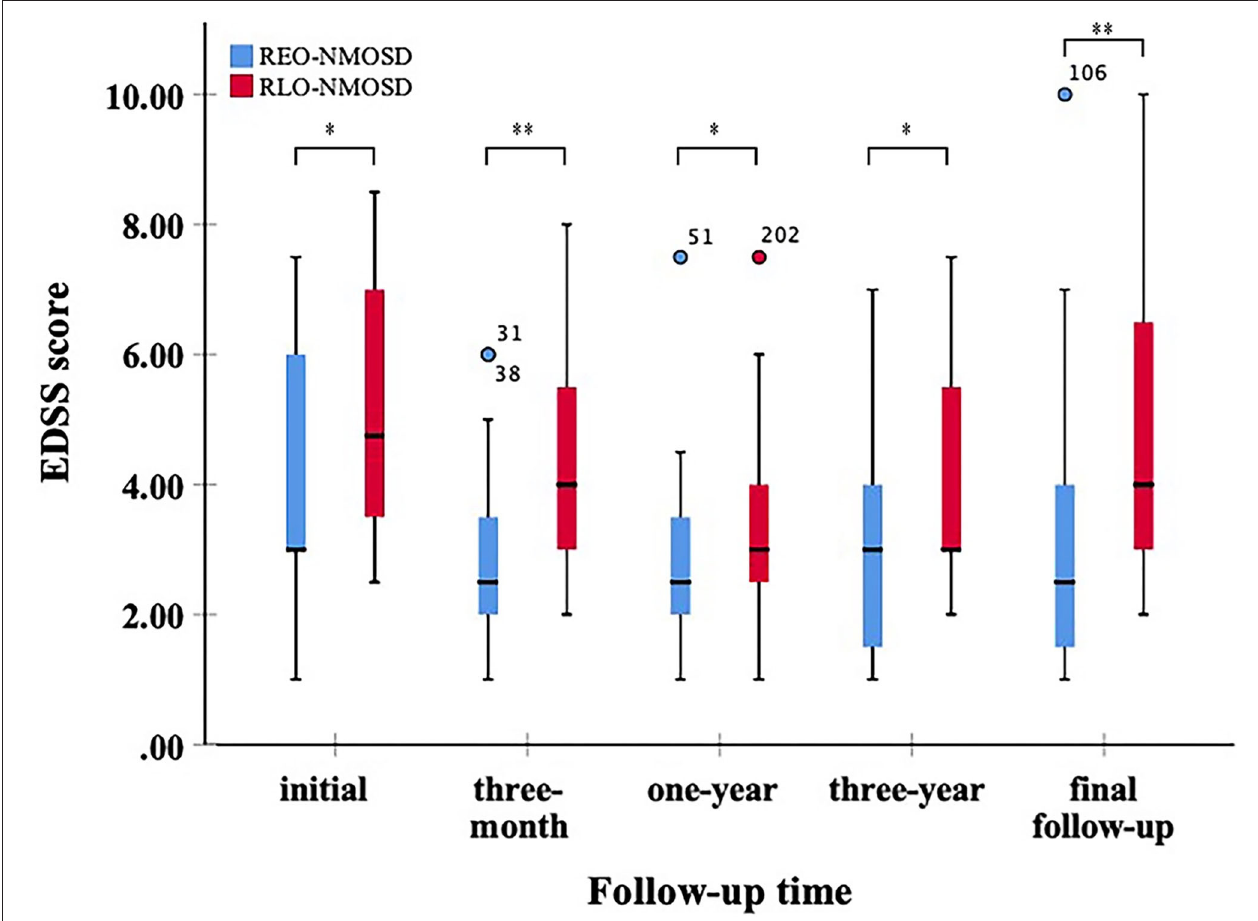
FIGURE 5 | Expanded disability status scale scores at different points between patients with REO- and RLO-NMOSD with AQP4-Ab positive (* p <0.05,** p